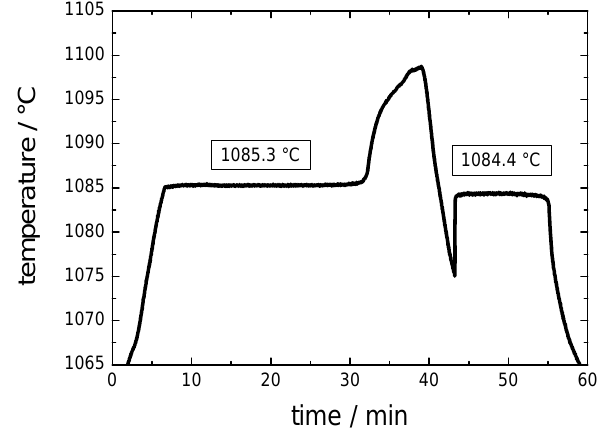
Figure 11. Melt and freeze cycle of a Cu fixed-point cell heated with an induction furnace containing a stainless steel tube as the heating element. Melting temperature: 1084.62 ◦ C. Measured with the thermal imaging system E-MAqS (Fraunhofer IWS Dresden) with a measuring wavelength of